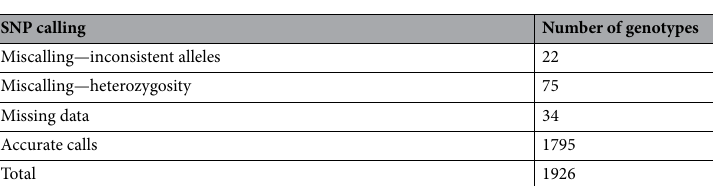
Table 1. SNP calling quality assessed for the 107 SNPs genotyped in 18 haploid individuals (honey bee males) using the iPLEX MassARRAY system. Calls were compared with those obtained with the Illumina HiSeq 2500 platform for the same